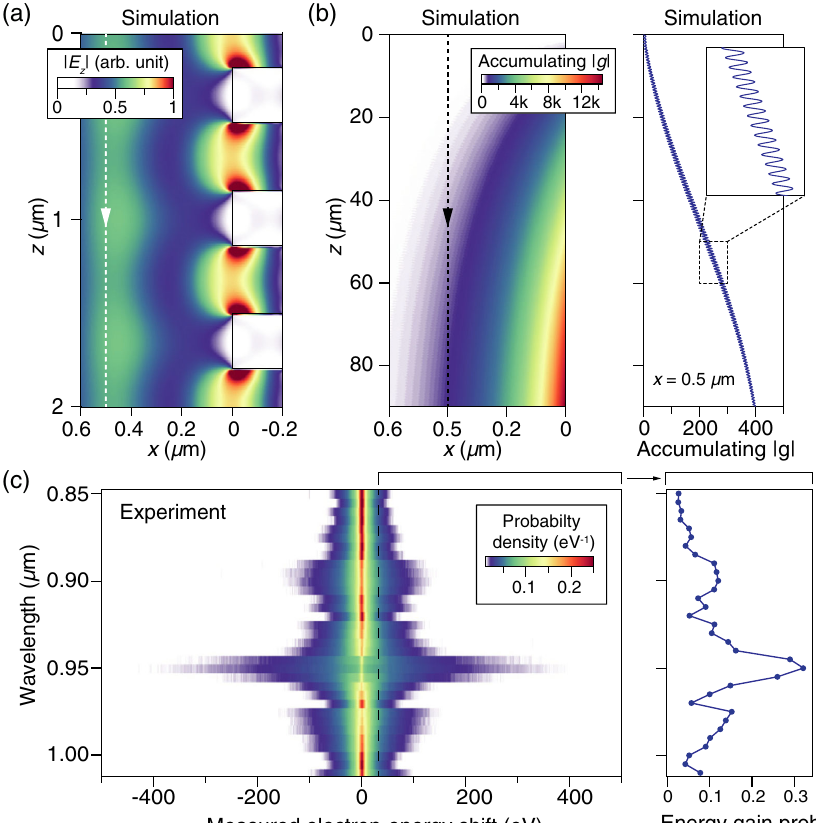
FIG. 2. The DLA near-field simulation and its measured wavelength dependence. (a) A finite-difference time-domain simulation of the electric field (polarization parallel to the electron trajectory in an absolute value), which causes the electron acceleration. The DLA structure alters the near-field pattern to achieve both a longitudinal field component and a phase-matching condition that facilitate efficient interaction. Note that the range 0 < x < 0 . 2 μ m is inside the grating and therefore cannot be accessed by the electrons. Most of the presented range 0 < x < 0 . 6 μ m is outside the grating and accessible by the electrons. (b) The left panel shows the integrated coupling strength accumulated along the interaction of the electron with the DLA as simulated using Eq. (2). The right panel shows a cross section of this coupling strength at x ¼ 0 . 5 μ m, which is 500 nm away from the grating surface, approximately the distance of the center of the electron beam at the measurement depicted in Fig. 3 (see the Supplemental Material [46] for these measurement parameters). The inset highlights the oscillations of the coupling strength resulting from the grating near-field periodicity. (c) The left panel depicts a wavelength scan response of the DLA structure — EELS measurements for different wavelengths between 850 and 1010 nm with a 5-nm step — showing maximal interaction in the wavelength of 950 nm, in agreement with the theoretical design. This measurement tests the structure wavelength response and shows the accuracy of the fabricated periodicity. For the right panel, we sum the number of electrons that gain at least 6 eV (i.e., outside of the ZLP) for each wavelength, corresponding to the probability of electrons to gain energy from the DLA near field, showing a peak at the resonant